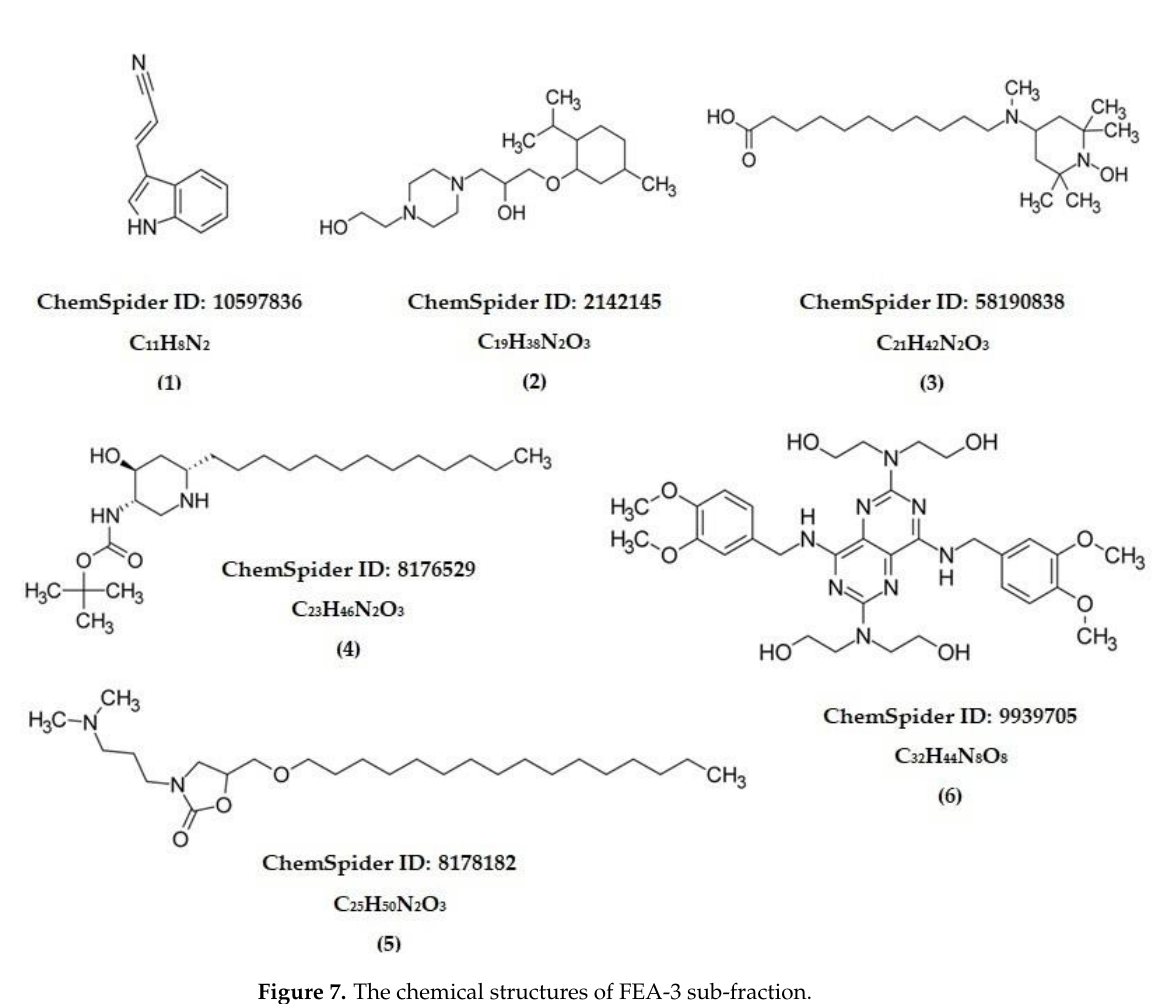
Figure 7. The chemical structures of FEA-3 sub-fraction.